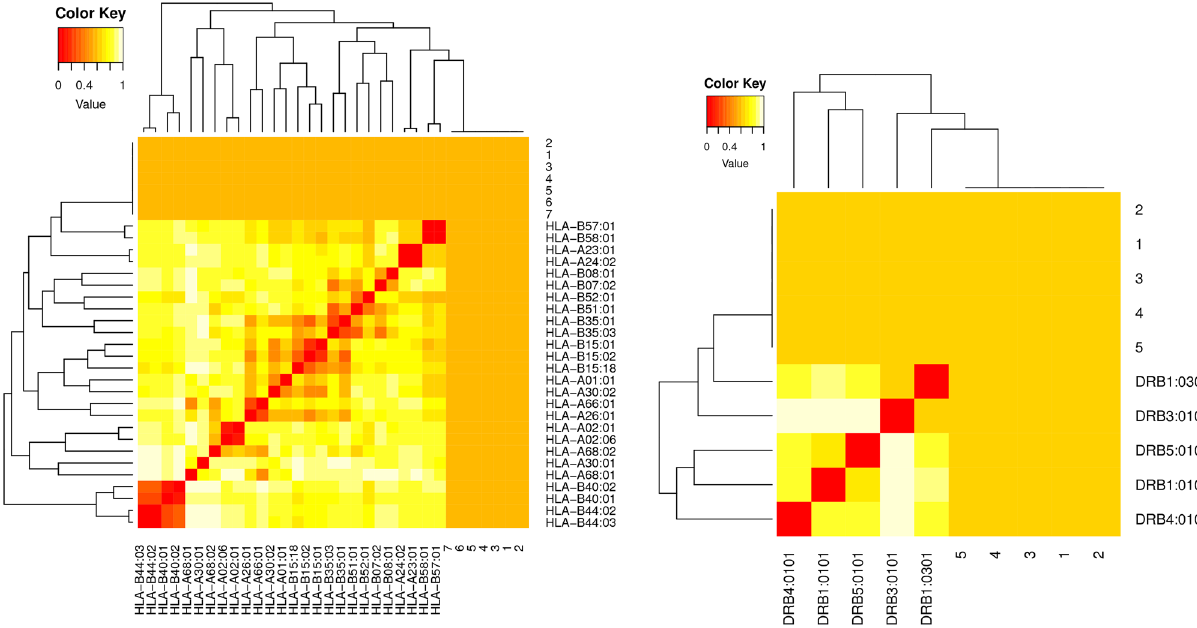
Figure 3. Clustering Analysis for MHC I and II epitopes. The Cluster analysis of MHC molecules and HLA alleles ( A ), MHCI clustering alleles, ( B ) MHCII clustering alleles. Red color indicating strong interaction while yellow zone indicates the weaker